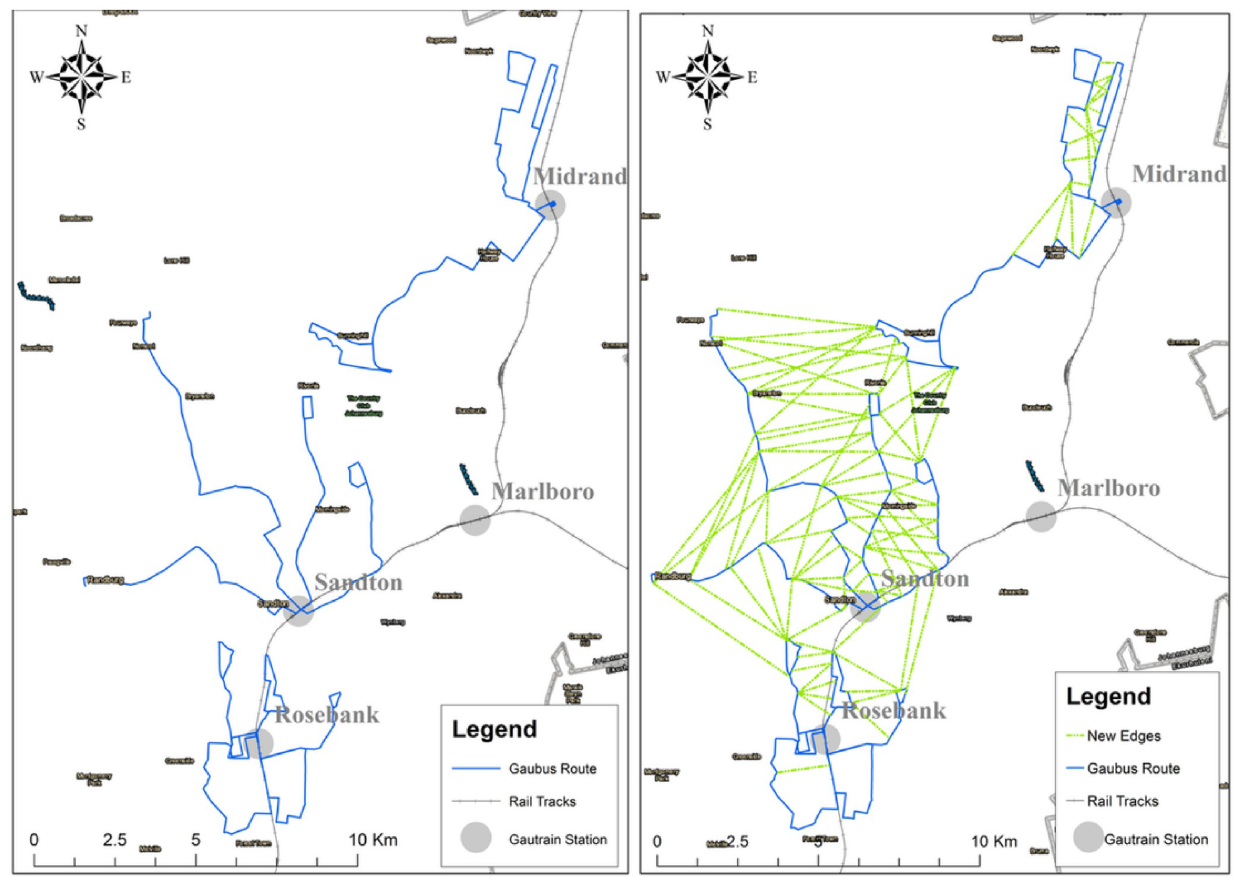
Fig 8. Potential augmented Gaubus network after adding edges in E